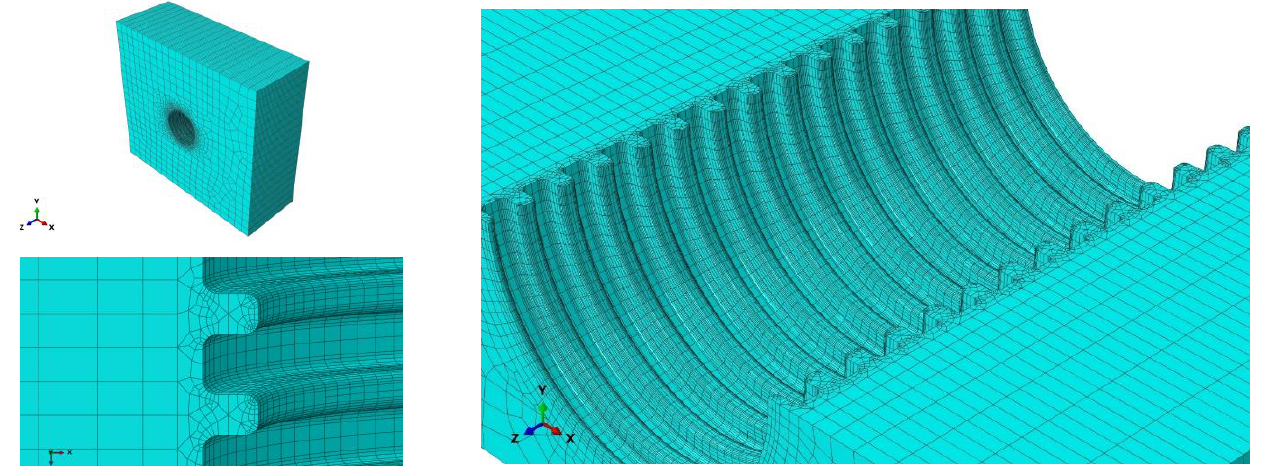
Figure 4. Elements of soil.